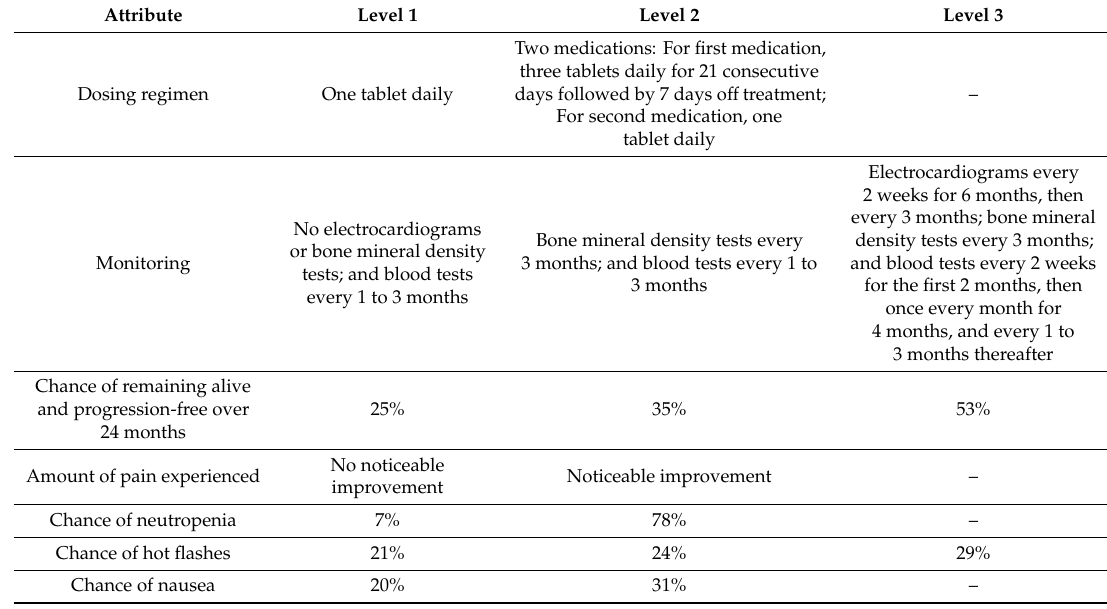
Table 1. Attributes and levels included in the discrete choice experiment